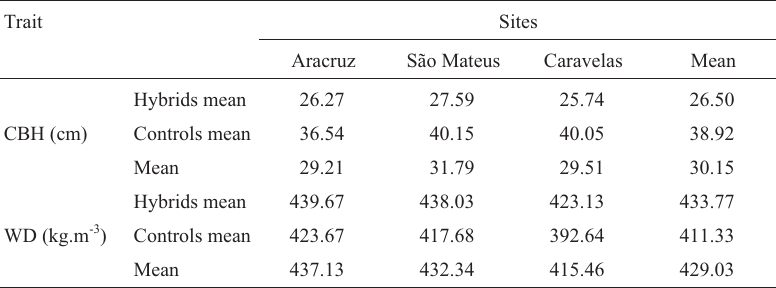
Table 2 - Means of hybrids and controls for circumference at breast height (CBH) and wood density (WD) obtained in the evaluation of diallel crossings of two-year-old Eucalyptus globulus and elite clones. Trait